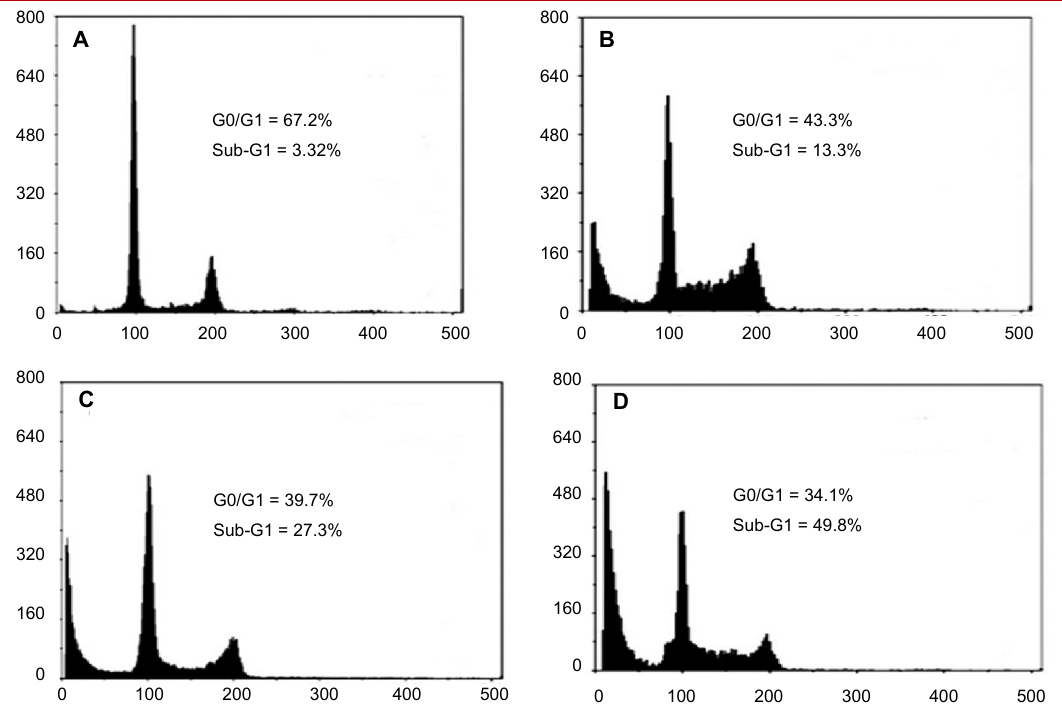
Figure 6: Effect of daucosterol on the cell cycle phase distribution in HCT-116 human colon carcinoma cells. The cells were treat- ed with 0 (A-0.5% DMSO-PBS), 5 (B), 50 (C) and 100 µM (D) dose of daucosterol and then incubated for 48 hours stained with propidium iodide and then analyzed by flow cytometry. The percentage of cells in sub-G1 phase continuously increased from 3.32% in control group to 12.4%, 28.3% and 47.6% in groups treated with 5, 50 and 100 µM dose of daucosterol respectively